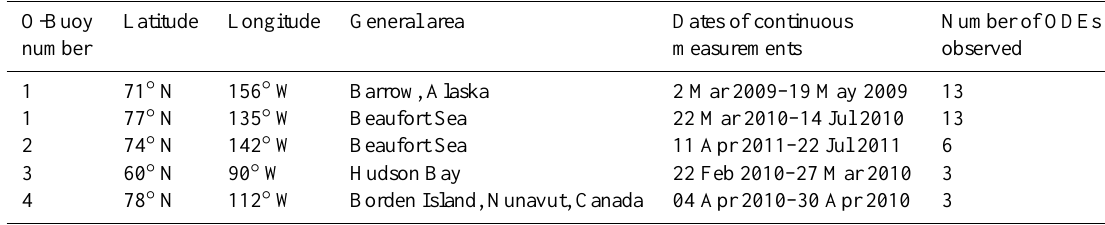
Table 1. O-Buoy deployment locations and time periods of continuous measurements focused on herein. O-Buoy Latitude Longitude General area Dates of continuous Number of ODEs